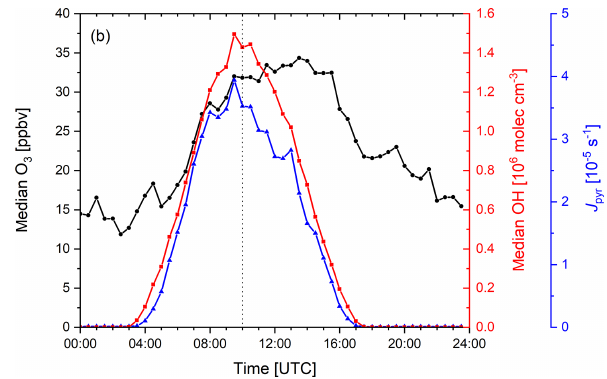
Figure 4. Diel profiles of median mixing ratios of O 3 , OH and J pyr (calculated with a quantum yield of 0.2) during the IBAIRN cam-